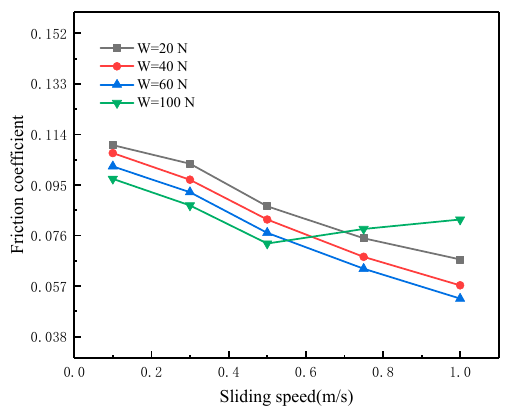
Figure 5. Variation of friction coefficient with sliding speed.